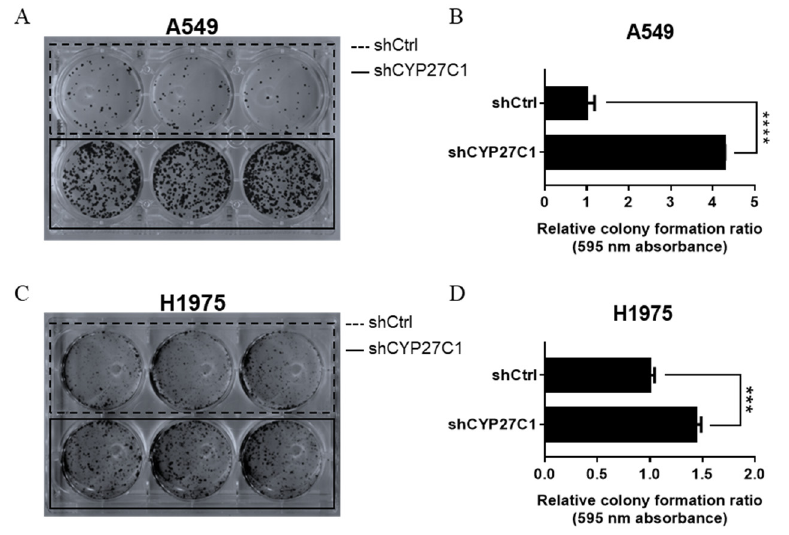
Figure 4. Stable CYP27C1-knockdown enhances colony formation ability of lung cancer cells. ( A – D ) A549-shCYP27C1, H1975-shCYP27C1, and the corresponding control cells were seeded in 6-well